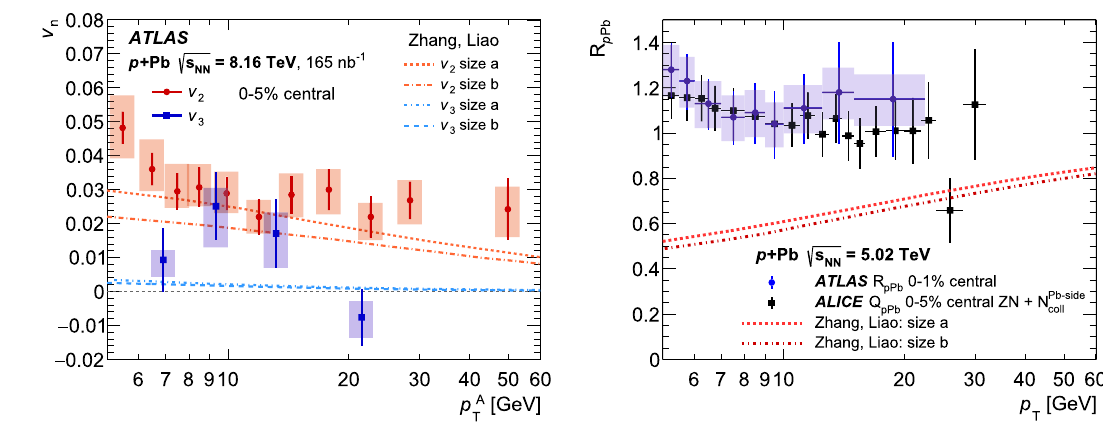
are v 2 for ‘size a’ (dotted) and ‘size b’ (dash-dotted) configurations, and the lower two (blue) are v 3 where the ‘size a’ (dash-dotted) and ‘size b’ (dashed) curves are nearly indistinguishable from each other. The right panel shows R p Pb data from ATLAS [57] and Q p Pb data from ALICE [41]. Theoretical calculations (red/orange lines) from Ref. [14] are also shown in this panel; the dotted line gives the results of the ‘size a’ configuration and the dash-dotted line gives the results of the ‘size b’ configuration